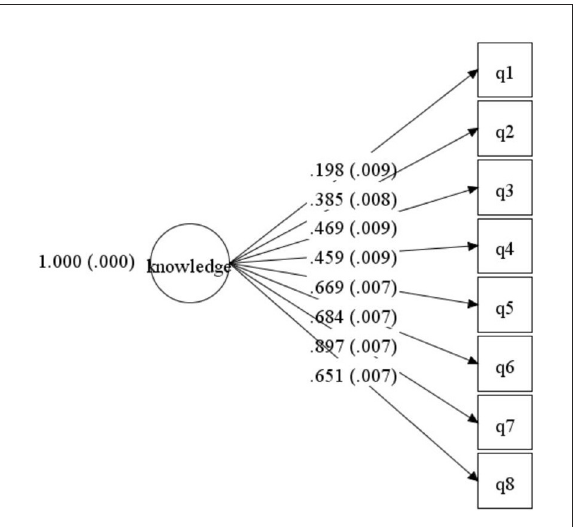
FIGURE1 Structural validity of the HIV/AIDS knowledge